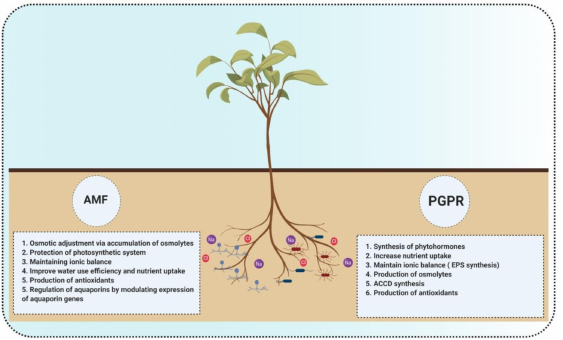
Figure 4. PGPR and AMF mechanisms for salt stress amelioration in plants: common and different mechanisms used by PGPR and AMF to combat salt